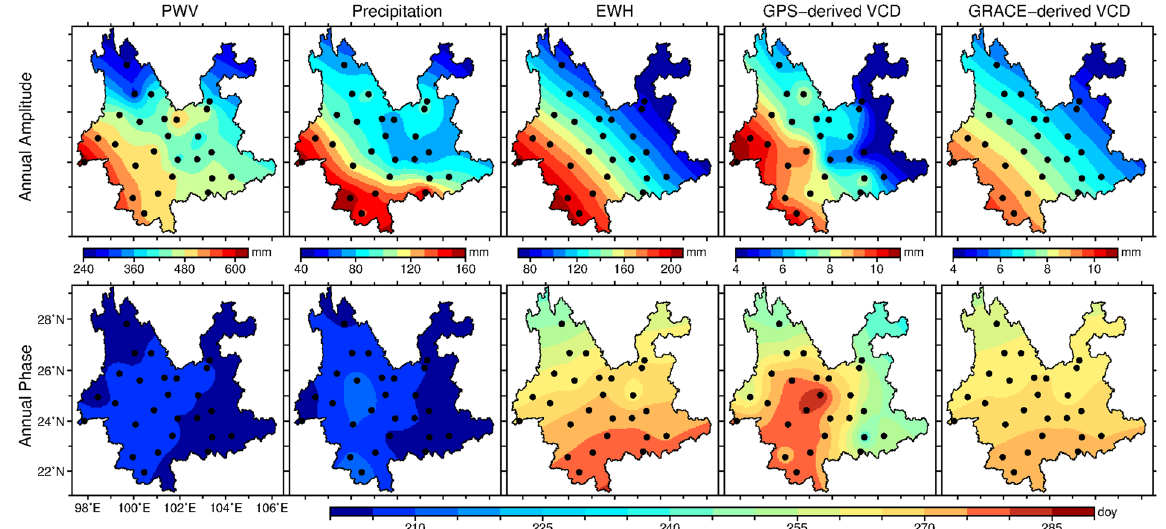
Figure 3. Maps of annual amplitude (upper panel, unit: mm) and phase (lower panel, unit: day of year) of PWV, precipitation, EWH, GPS-derived and GRACE-derived VCD. The annual phase is the day of the year (doy) when an annual signal reaching its maximum. This figure is generated by using the Generic Mapping Tools (Version 5.3.1) 26